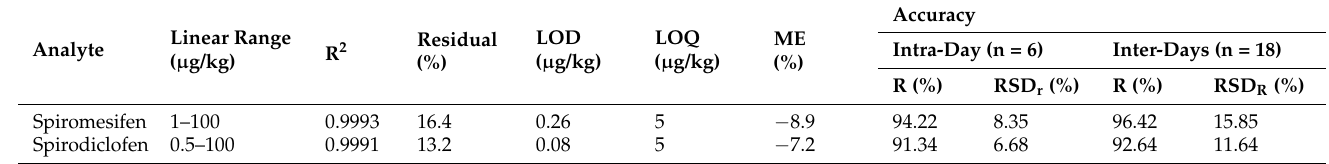
Table 2. Calibration parameters, LOD, LOQ, ME (%), and accuracy of spiromesifen and spirodiclofen in tomato fruits.